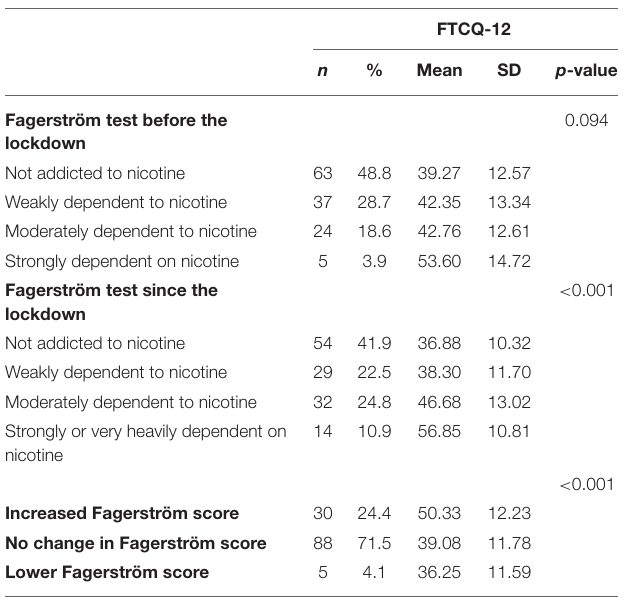
TABLE 2 | Impact of Fagerstöm Test related to the lockdown and correlation to FTCQ-12.